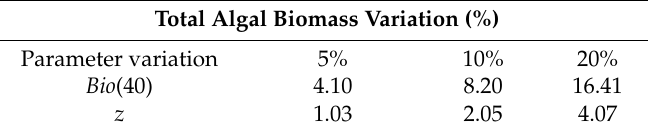
Table 2. Sensitivity analysis of the total algal biomass algorithm under algal bloom conditions.